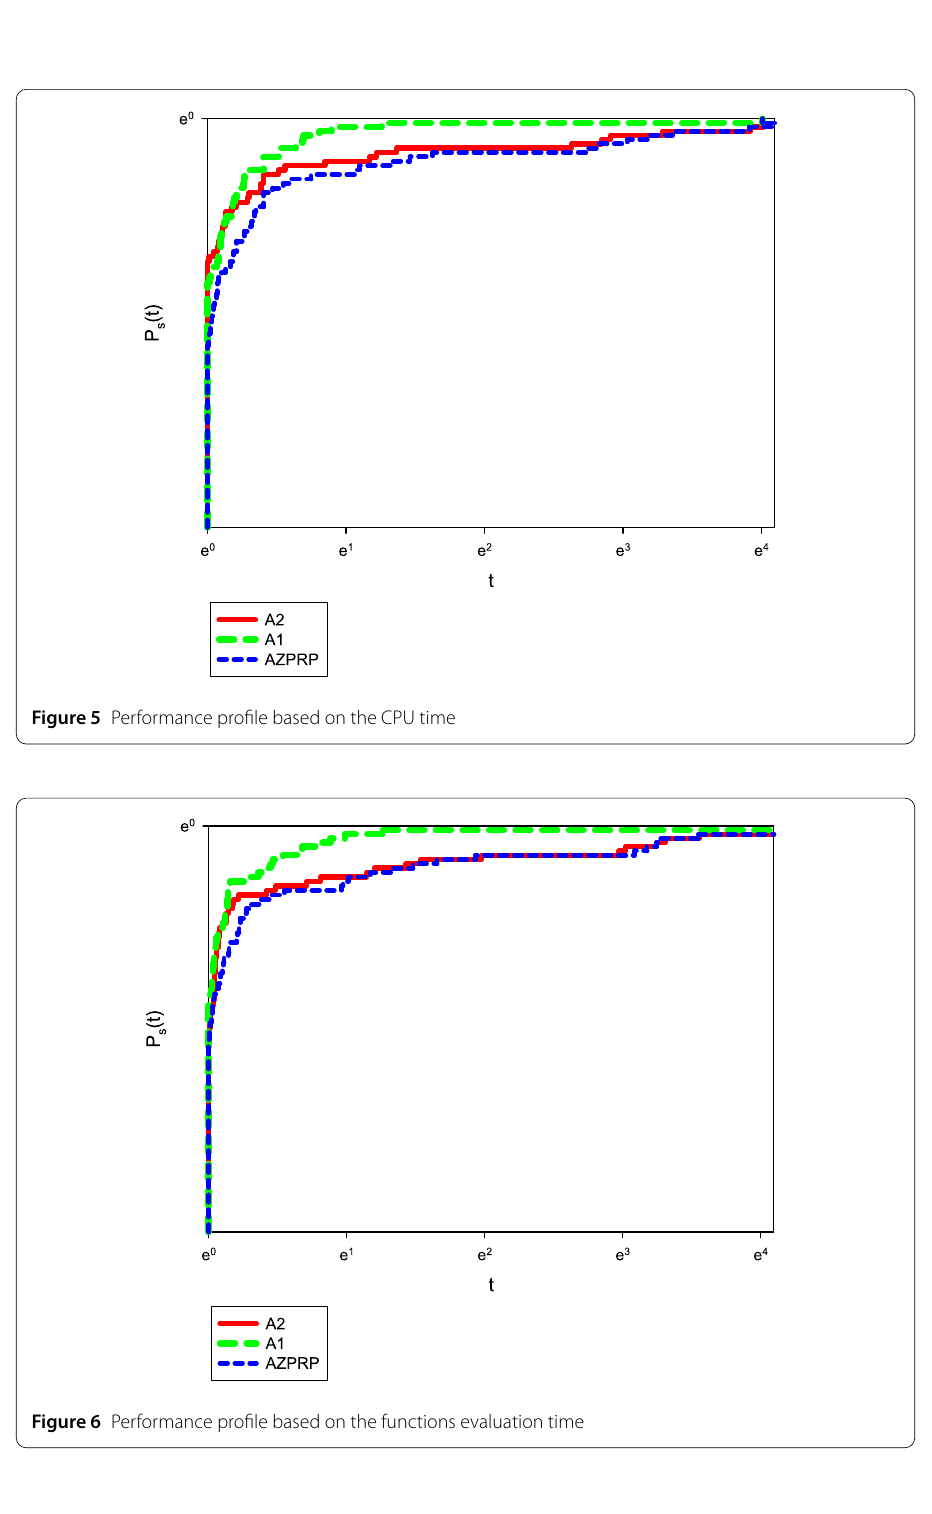
The comparison was made with respect to CPU time, the number of function evalu- ations, the number of iterations, and the number of gradient evaluations. The SWP line search is employed with the following parameters of δ = 0.01 and σ = 0.1. The modified CG-Descent 6.8 with zero memory is employed to obtain the result for β A 1 can be downloaded from the Hager